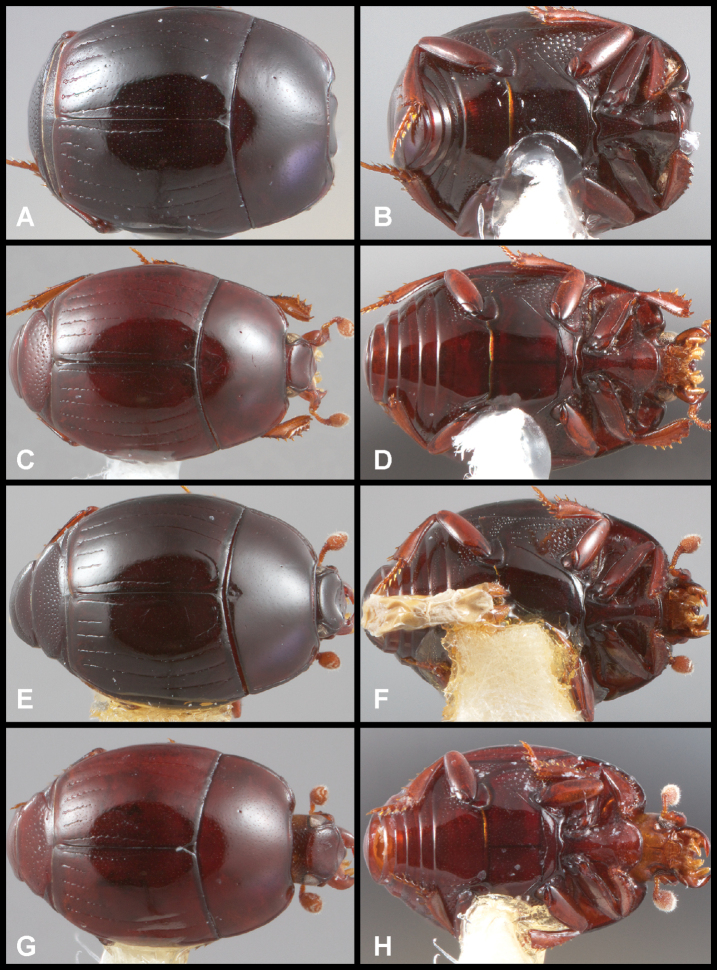
A, BPhelister
rio: A dorsal habitus B ventral habitus C, DP.
semotus: C dorsal habitus D ventral habitus E, FP.
uncinatus: E dorsal habitus F ventral habitus G, HP.
inscriptus: G dorsal habitus H ventral habitus.